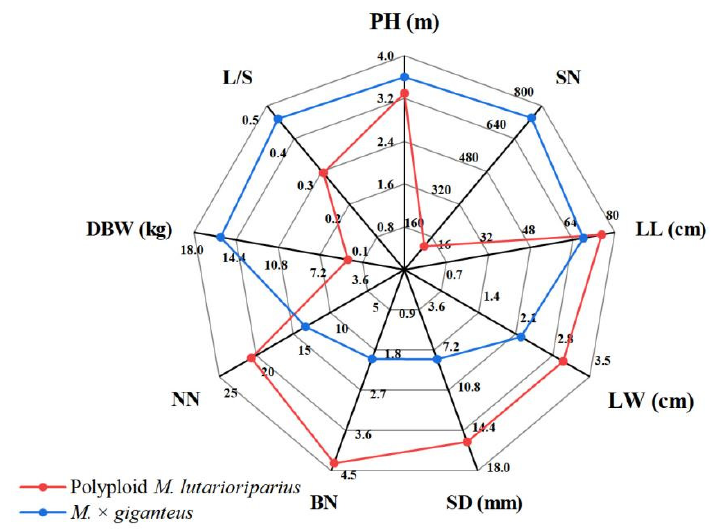
Figure 1. Agronomic traits of polyploid Miscanthus lutarioriparius and Miscanthus × giganteus . Dry biomass weight (DBW), leaf/stem ratio (L/S), Panicle height (PH), Stem number (SN), Leaf length (LL), leaf width (LW), stem diameter (SD), Node number (NN). (LL), leaf width (LW), stem diameter (SD), Node number